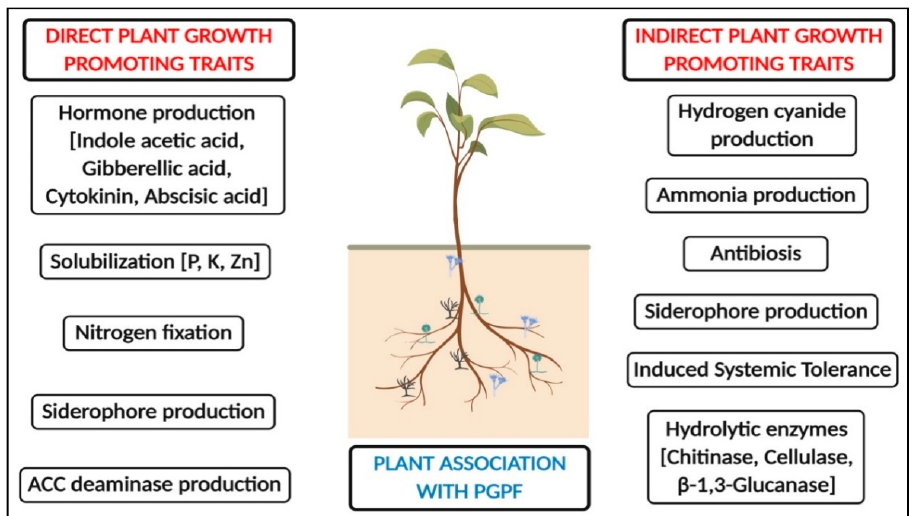
Figure 1. Outlook on the beneficial characteristics of rhizosphere-resident plant growth promoting fungi (PGPF) for plant growth.